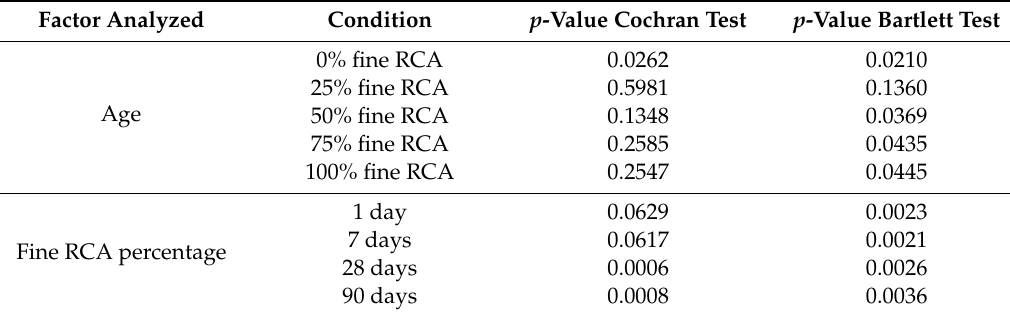
Table 11. p -value for both the Cochran test and the Bartlett test.